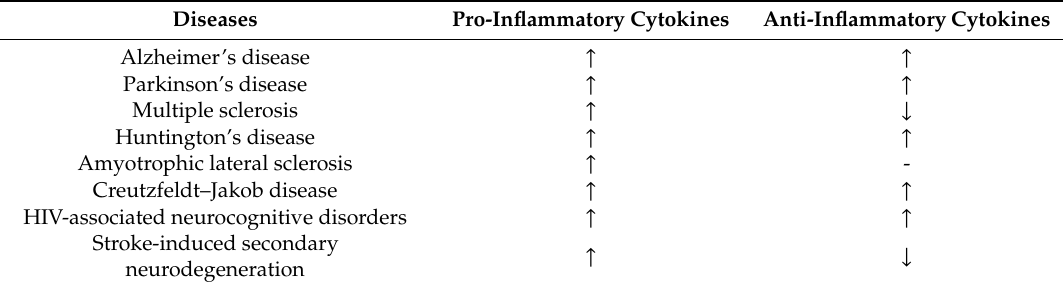
Systematic synthesis of pro-inflammatory and anti-inflammatory cytokine levels in neurodegenerative diseases. ↑ : increase; ↓ : decrease; -: unchanged. HIV—human immunodeficiency